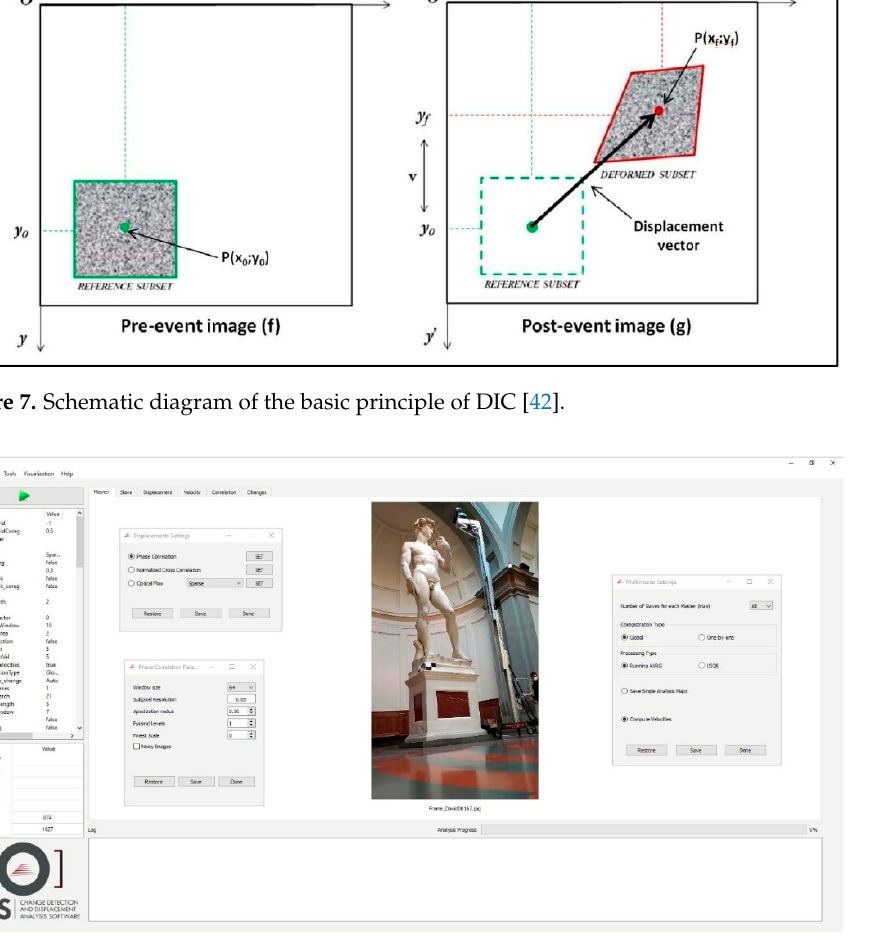
Figure 7. Schematic diagram of the basic principle of DIC [42].